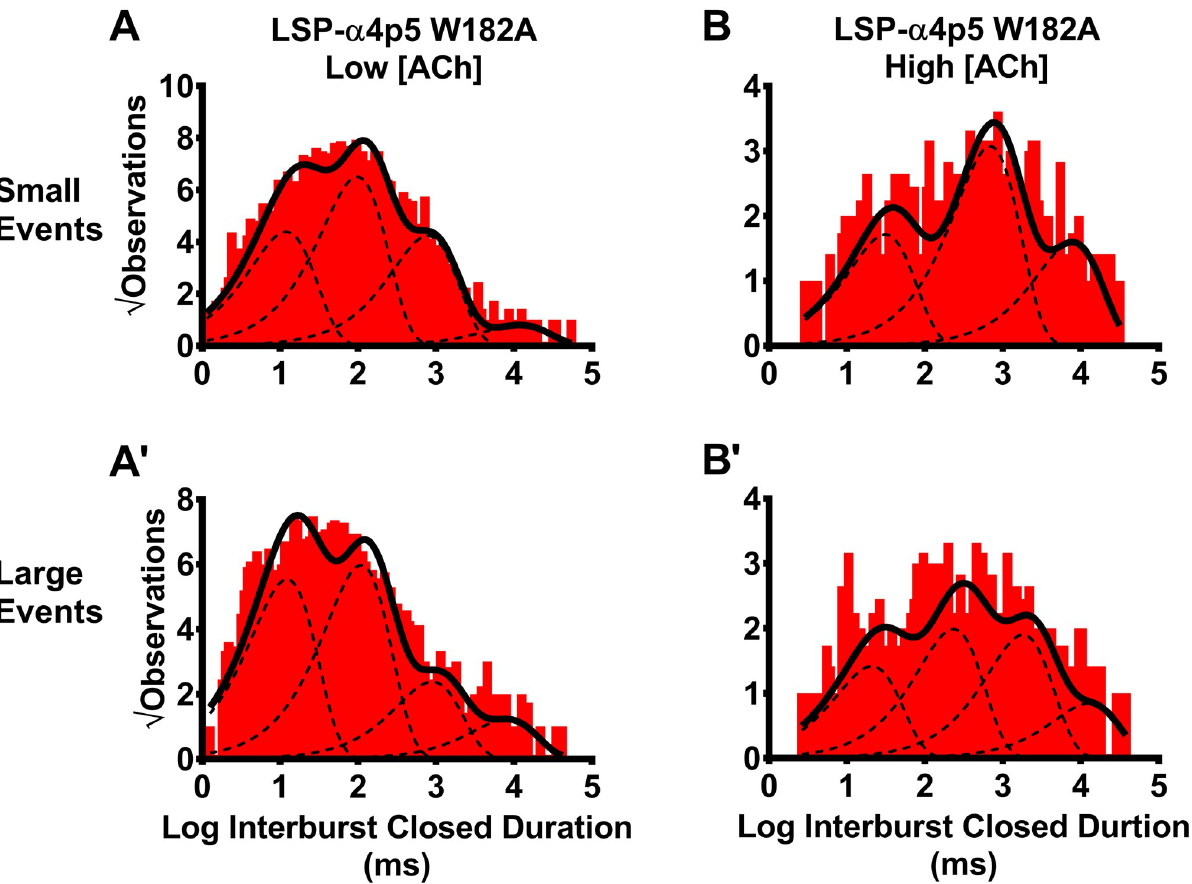
Fig 9. Closed dwell durations between small and large amplitude bursts of human LSP- α 4p5W182A-nAChR. LSP ( α 4 β 2) 2 α 4-nAChR were expressed in X . laevis oocytes from a concatenated cDNA construct in which the critical tryptophan-182 amino-acid was mutated to alanine (W182A) in only the low-affinity α 4/ α 4-interface agonist binding site (red bars). Closed durations between bursts of activity in the presence of a low ACh concentration (0.7 μ M) were determined for both small (A) and large amplitude (A’) bursts. As for the parent LSP construct, interburst closed durations at the low ACh concentration were best described using four time constants, regardless of whether small or large amplitude bursts were considered. The effects of changing to a higher ACh concentration (30 μ M) on interburst closed durations differed between the two amplitude classes of bursts. For bursts of small amplitude events (B) , the number of time components was reduced to three, likely due to disappearance of the second- shortest time component ( τ S2 ). In this interpretation, the shortest time constant increased significantly while small, but significant, shortenings of the two longest time constants ( τ S3 , τ S4 ) were also seen. These shortenings were much less dramatic than those observed for the parent LSP construct (compare to Fig 6). For bursts of large amplitude events (B’) , the increased ACh concentration did not alter the number of interburst closed dwell duration components detected. However, each time constant was significantly lengthened; this is the opposite of the behavior of the parent LSP construct. Data were collected from 7 individual patches, across at least three separate experiments, for each panel of the Fig. The calculated τ values are summarized in Table 4, together with the statistical analyses applied.